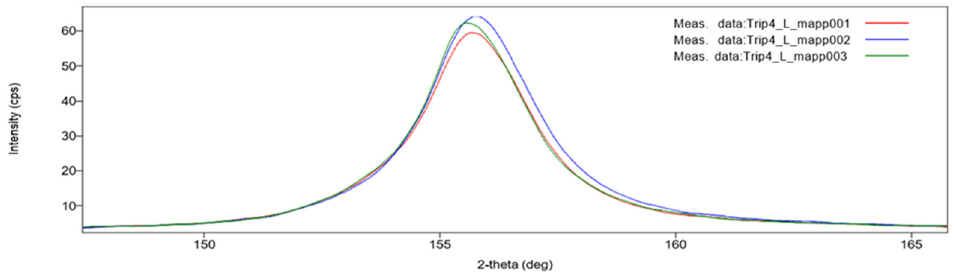
Figure 12. Austenite peaks (220) measured at three points for the TRIP 4 sample after impact bending test. Table 5. Fractions of retained austenite in samples submitted to impact bending tests, V γ 2 .